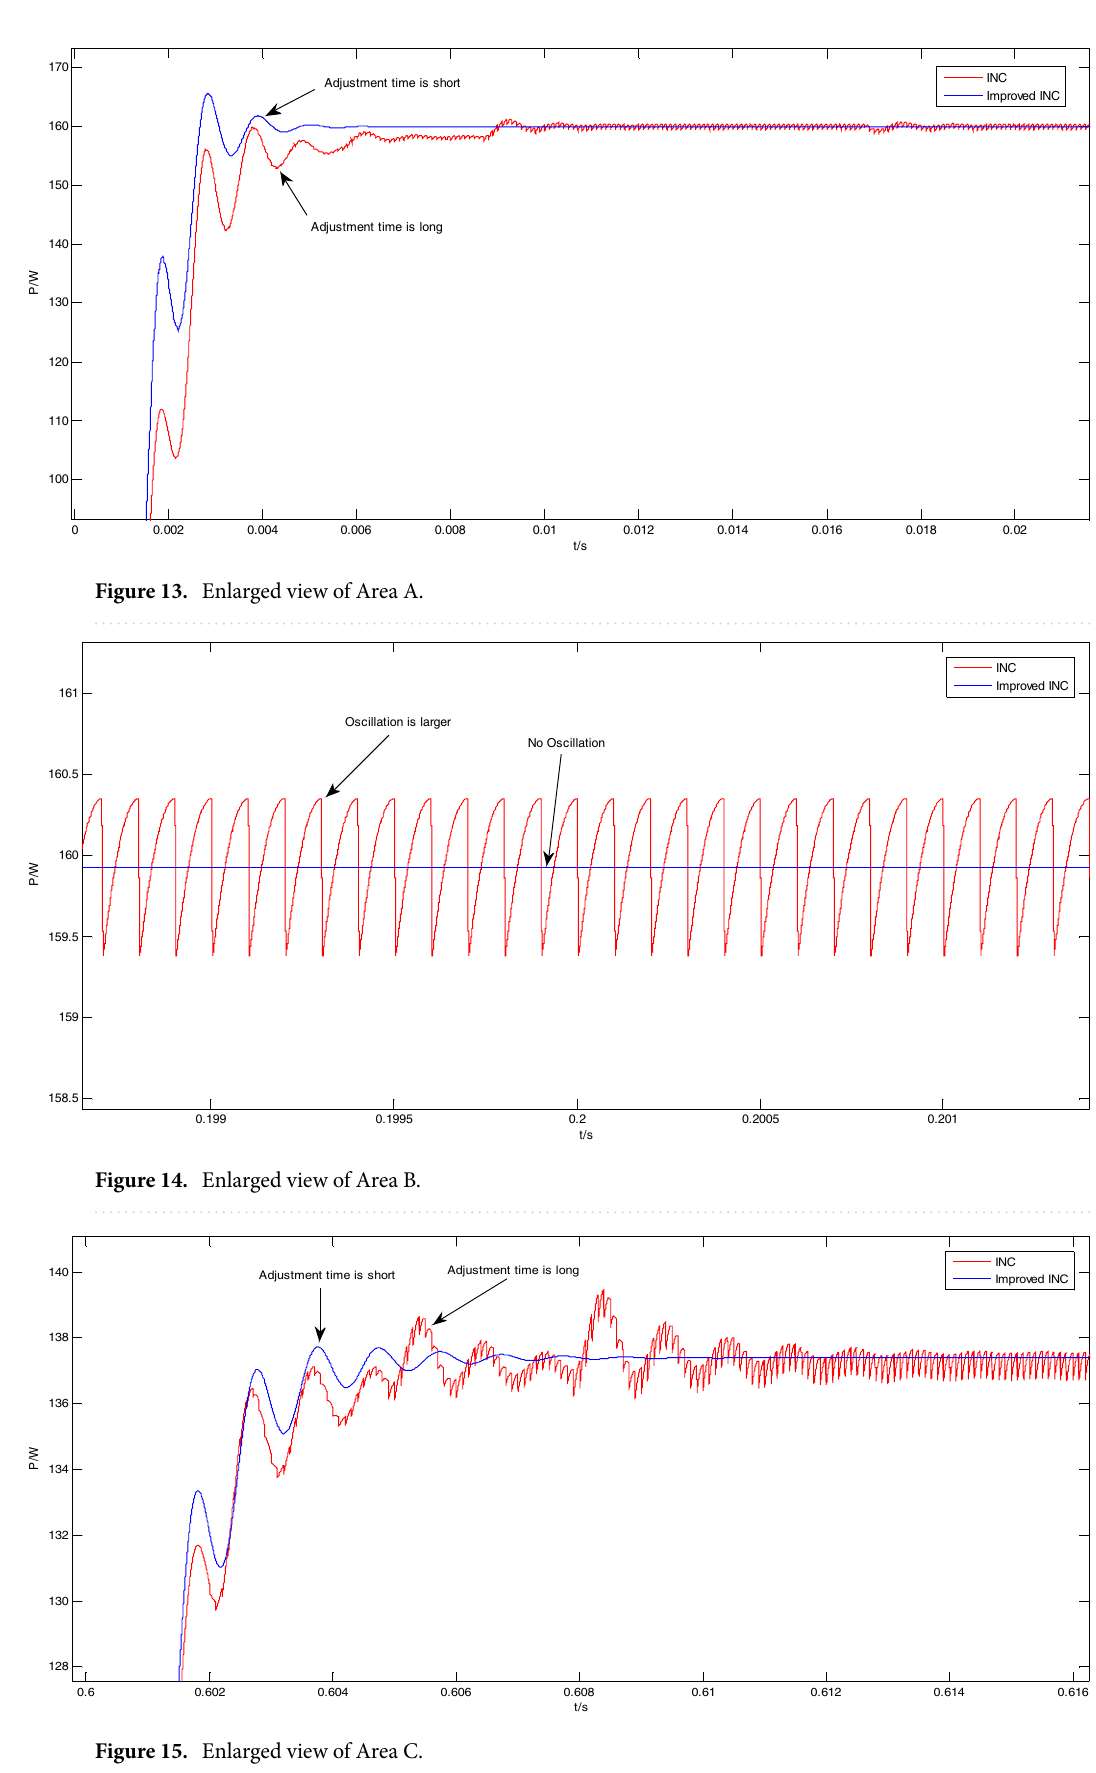
Figure 15. Enlarged view of Area